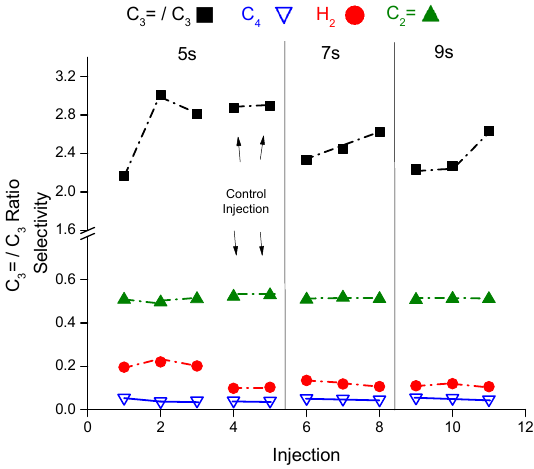
Figure 5. C 3 =/ C 3 ratio ( (cid:110) ), H 2 ( (cid:108) ), C 2 = ( (cid:115) ), and C4 ( (cid:53) ) selectivity as function of reaction time and ▽ injection number at 550 ◦ C recorded for the riser simulator Figure 5. C 3 = / C 3 ratio ( ⬛ ), H 2 ( ⚫ ), C 2 = ( ⯅ ), and C4 ( ) selectivity as function of reaction time and injection number at 550 °C recorded for the riser simulator reactor.